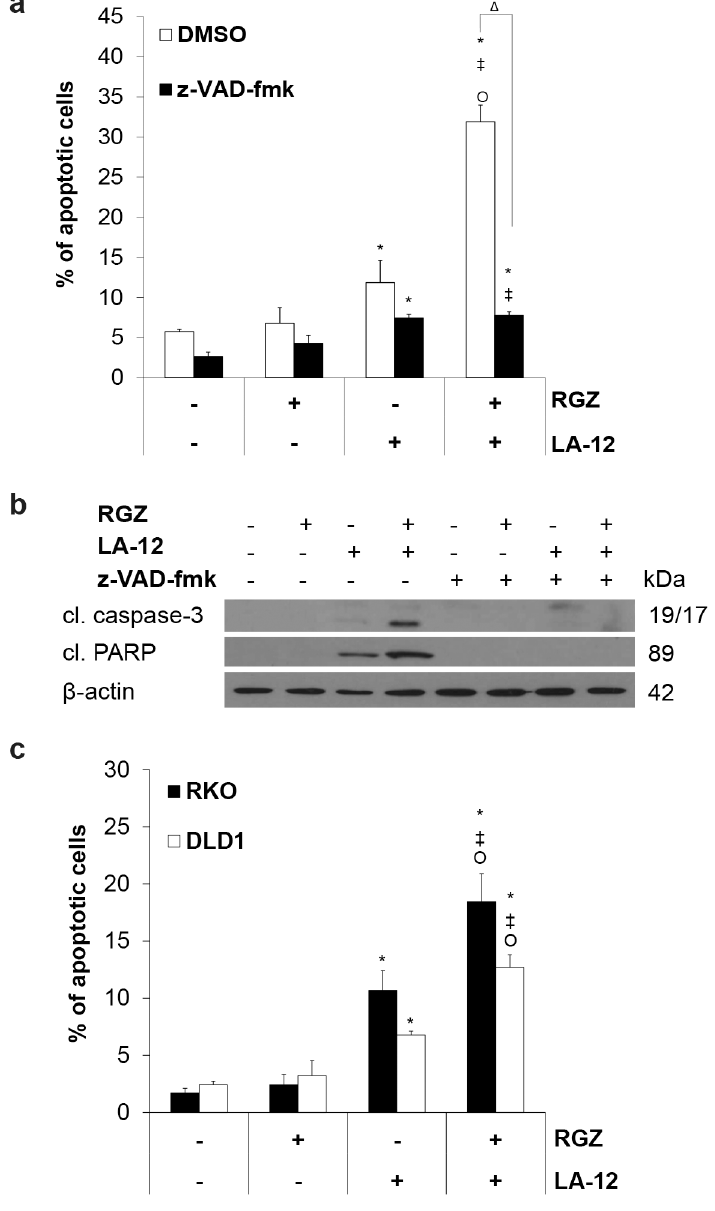
(b) cleavage of caspase-3 and PARP (Western blotting) following pretreatment (24 h) with rosiglitazone (RGZ, 50 μ M) and subsequent treatment (48 h) with LA-12 (0.75 μ M), in the absence (DMSO) or presence of z-VAD-fmk (10 μ M). (c) Percentage of apoptotic (annexin V positive/propidium iodide negative, flow cytometry) RKO or DLD1 cells following pretreatment (24 h) with rosiglitazone (RGZ, 50 μ M) and subsequent treatment (48 h) with LA-12 (0.75 μ M). Results are means + S.E.M. or representatives of three independent experiments. Statistical significance: P < 0.05, * versus control, ‡ versus RGZ, Ο versus LA-12, and Δ for with/ without